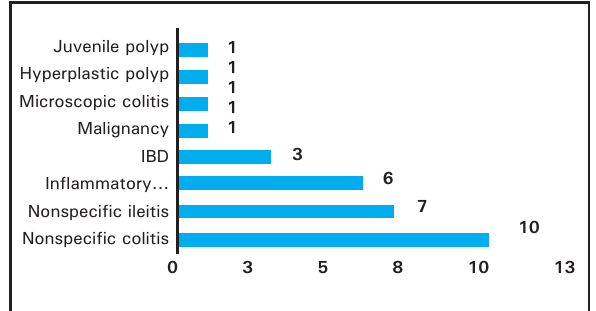
Figure 4. Histopathological findings in patients with